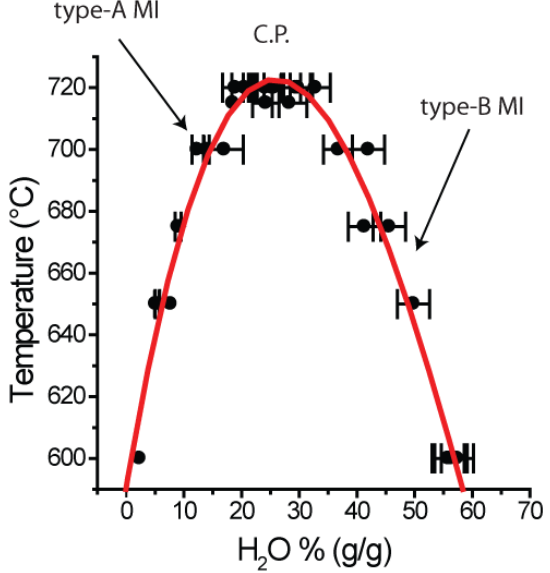
Figure 4. Pseudobinary water versus temperature plot of rehomogenized type-A and type-B melt inclusions in quartz from the Malkhan pegmatites. Points on the opposite side of the both solvus branches represent conjugate melt pairs. C.P—Critical Point of the system.